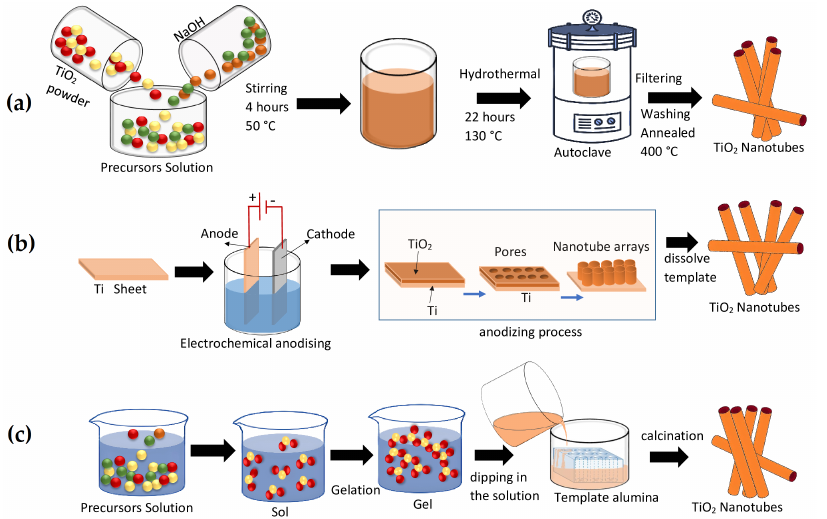
Figure 1. Schematic representation of the main production methods of TiO 2 nanotubes. ( a ) Hy- drothermal method. ( b ) Self-assembled electrochemical anodizing method. ( c ) Sol–gel